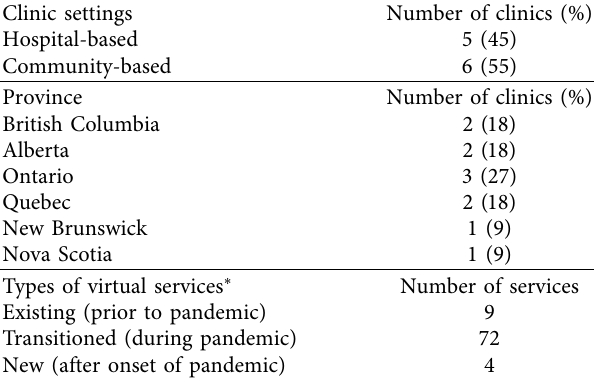
Table 1: Characteristics of participating pain clinics ( n �